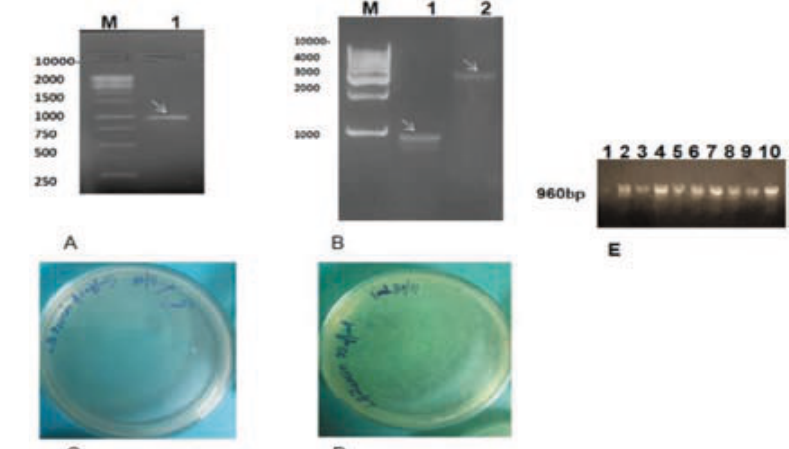
Fig.1. Cloning of Tf CP8 gene into pPICZα A vector and transformation into E. coli DH5 α with Zeocin selection. a. Amplified CP8 gene: M- DNA 1Kb ladder, 1- Amplified gene 960 bp. b. Preparation for Ligation: M- DNA molecular weight marker, 1- Double digested CP8 gene. 2- Double digested pPICZ α A vector. c- Negative control for cloning d- transformed recombinant pPICZα A-Tf CP8 positive colonies on LB Zeocin (25ug/ml